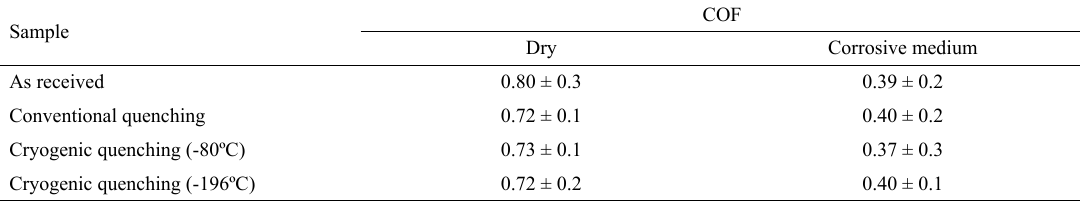
Table 8. COF values for all the samples for dry and corrosive conditions.